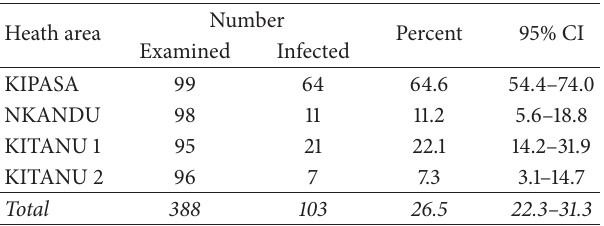
Table 2: Prevalence of Schistosoma mansoni infection in the four health areas of Kisantu health